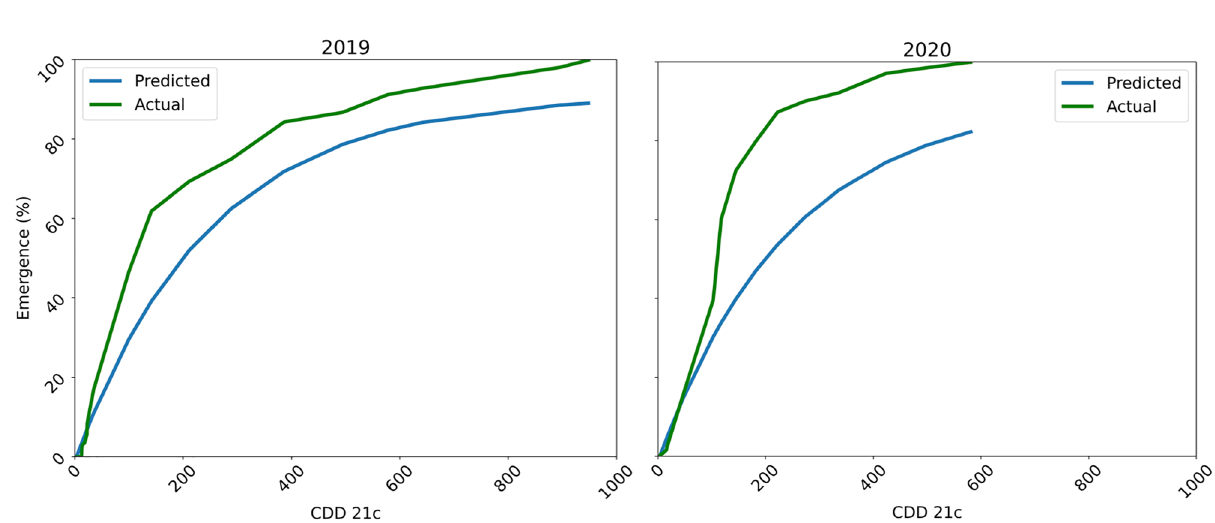
Figure 2. Four-parameter ruminal degradation curve to fit yearly cumulative P. annua emergence data collected at East Tennessee AgResearch and Education Center—Plant Sciences Unit (Knoxville, TN) in 2019 and 2020. Emergence was monitored on a weekly basis in plots (1 m 2 ) established as a hybrid bermudagrass ( C. dactylon L. Pers . x C. transvaalensis Burtt-Davy, cv. ‘Tifway’) fairway and maintained as bare soil. Combined observations were regressed over cooling degree day accumulation from the summer solstice using a 21 °C base temperature (CDD 21C ). The blue line represents model predictions whereas the green line represents actual observations each year. Measures of model fit for each year are presented in Table